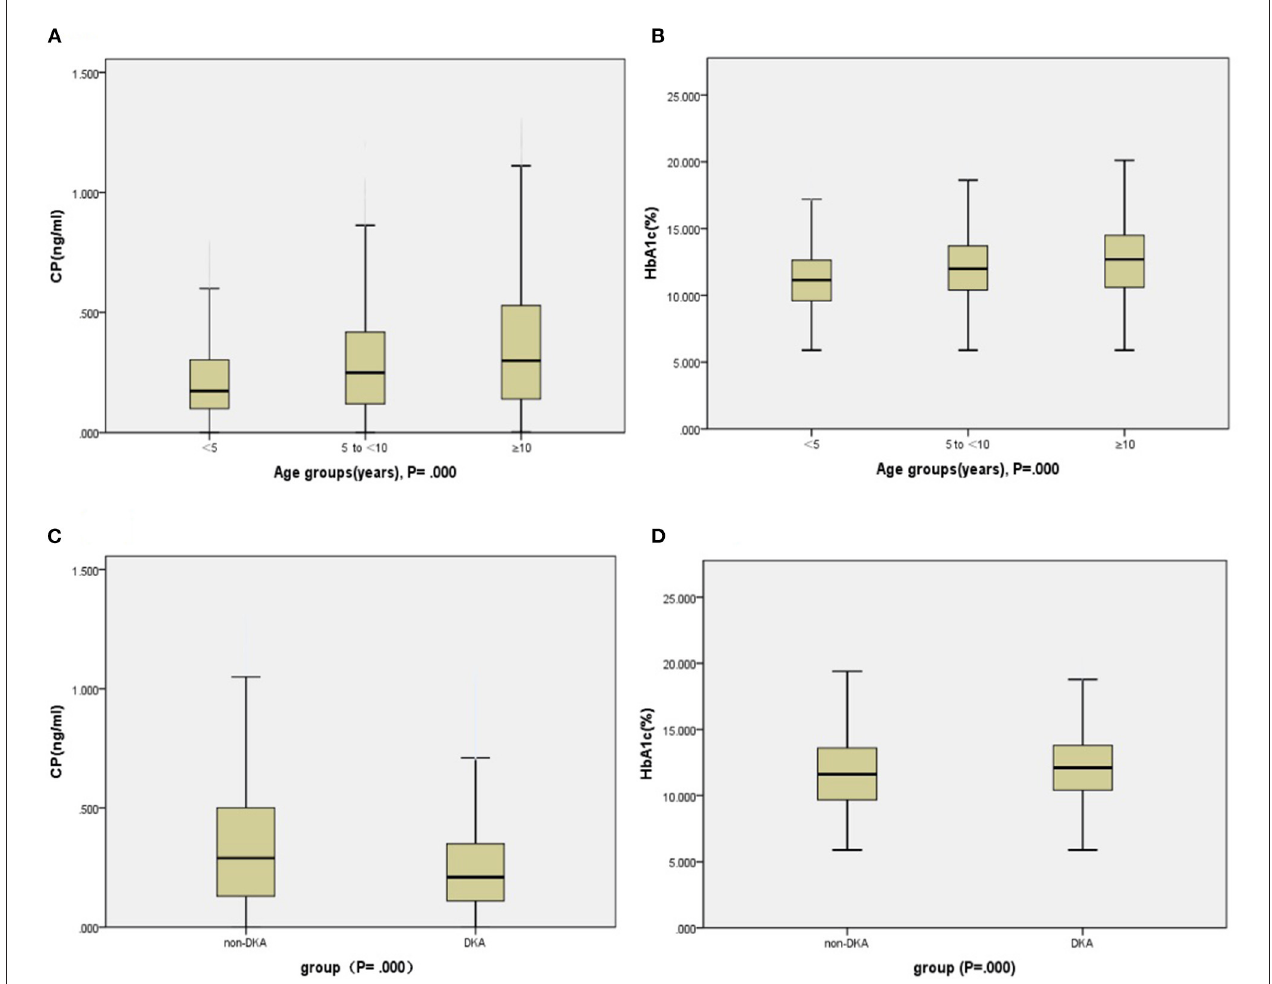
FIGURE 3 | Indices of insulin secretion (CP) and HbA1c in the participants. Panels (A,B) : Age groups. Panels (C,D) : DKA and non-DKA groups.